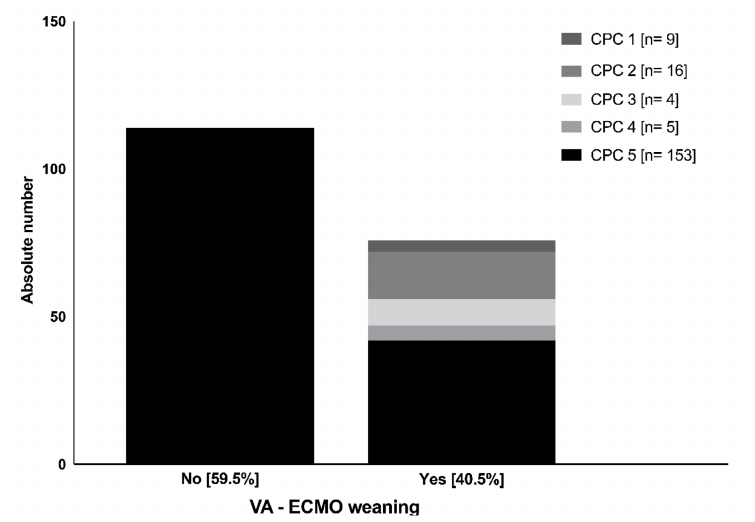
Figure 1. Number of cases of each CPC scale group after four weeks regarding VA-ECMO wean- ing status. CPC = cerebral performance category scale; VA-ECMO = veno-arterial extracorporeal membrane oxygenation.